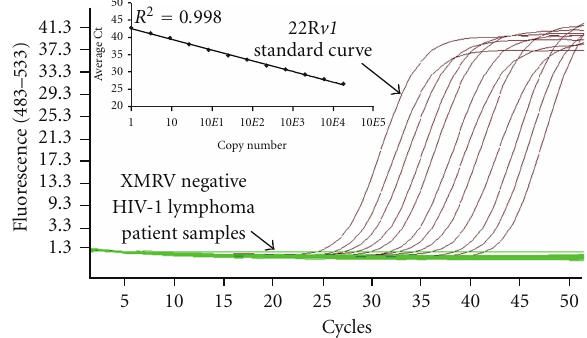
Figure 1: Real-time PCR analysis of HIV-1 lymphoma positive patients for XMRV. XMRV gag qPCR failed to detect XMRV from DNA isolated from PBMCs for the 26 HIV-1 lymphoma patients (green lines). Inset shows single-copy sensitivity of the